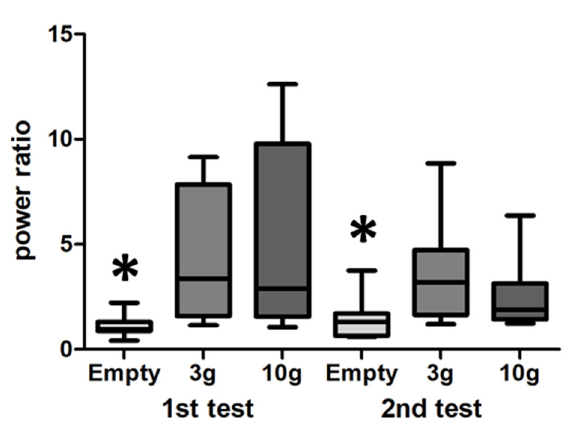
Figure 6. Effects of food odour stimulation on LFP recordings. ( Left ) In a first test, we observed that odour released from 3 g and 10 g of freshly crushed food pellets increased power in the beta-band frequency (15–40 Hz, power ratio: [power during the 2 s of stimulation/power for 2 s before the stimulation]) as compared to no odour (empty container) ( n = 9 rats). A second test of odour stimu-